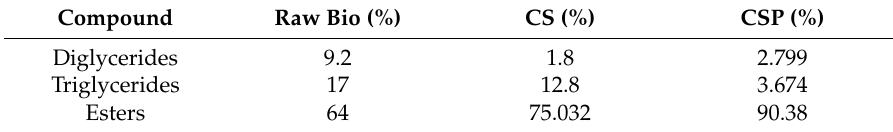
Table 4. HPLC analysis of biodiesel before and after adsorption process.